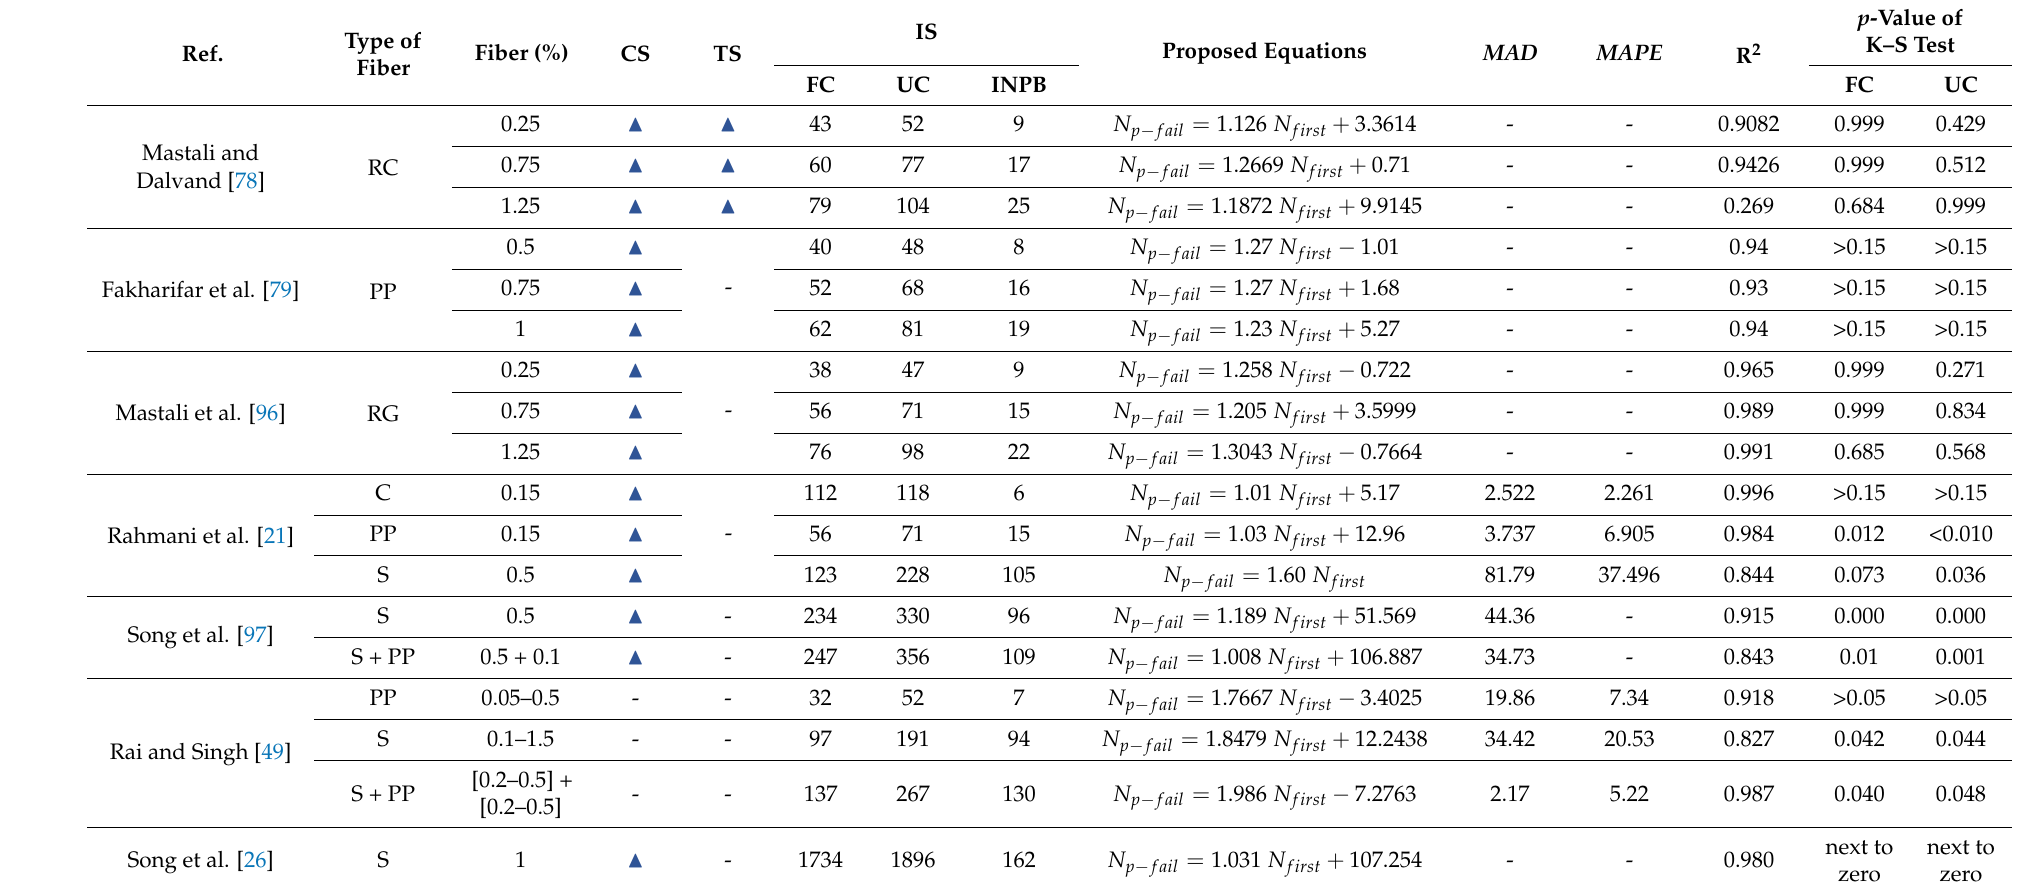
Table 13. Output parameters and process of experiments in previous